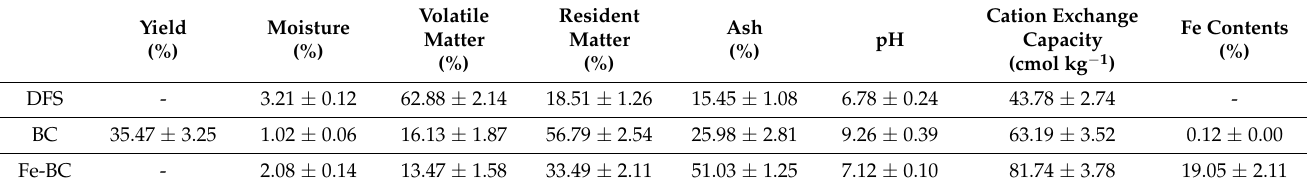
Table 1. Some chemical and proximate analyses of date palm waste (DFS), biochar (BC), and Fe- modified biochar